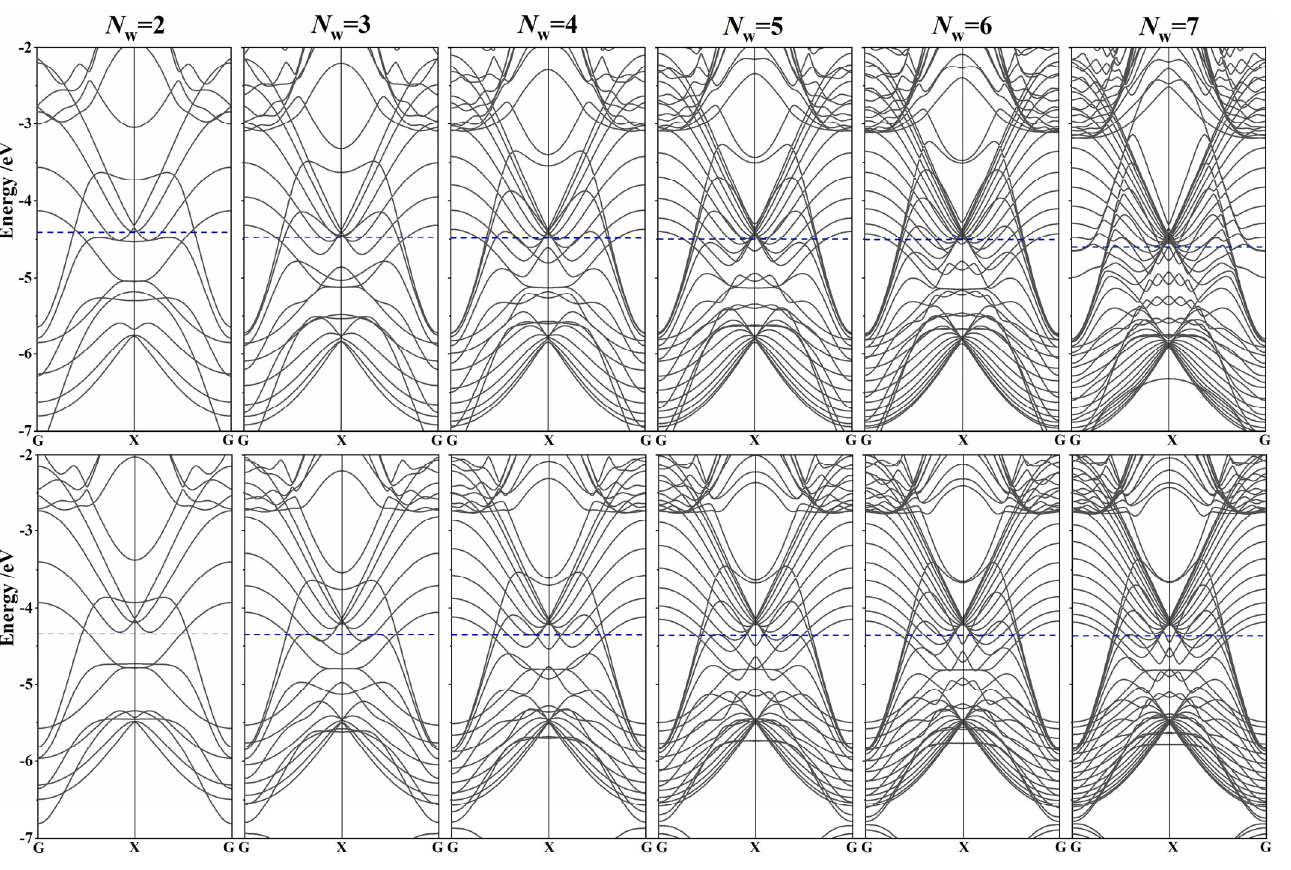
Figure 2. Band structures of Sb ( top panels ) and Bi ( bottom panels ) monolayer zigzag nanoribbons for diverse widths ( N w = 2~7). Vacuum free electron energy is set as energy zero and Fermi level is indicated by horizontal dash line.